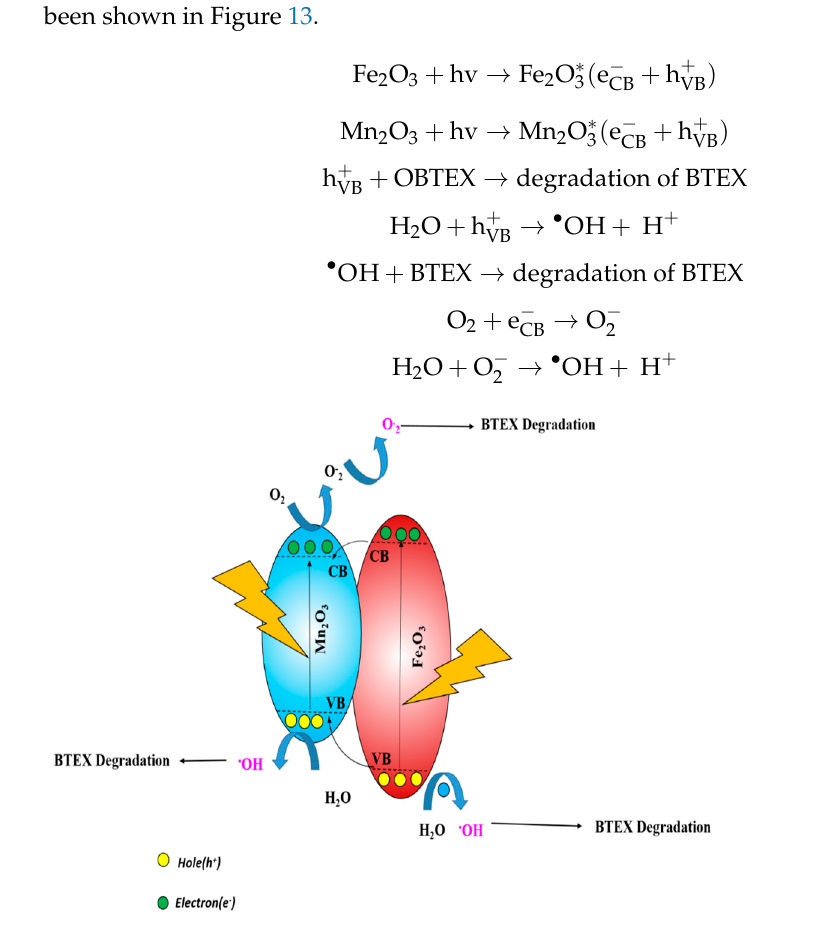
Figure 13. The degradation mechanism of BTEX on the surface of Fe 2 O 3 -Mn 2 O 3 /SiO 2